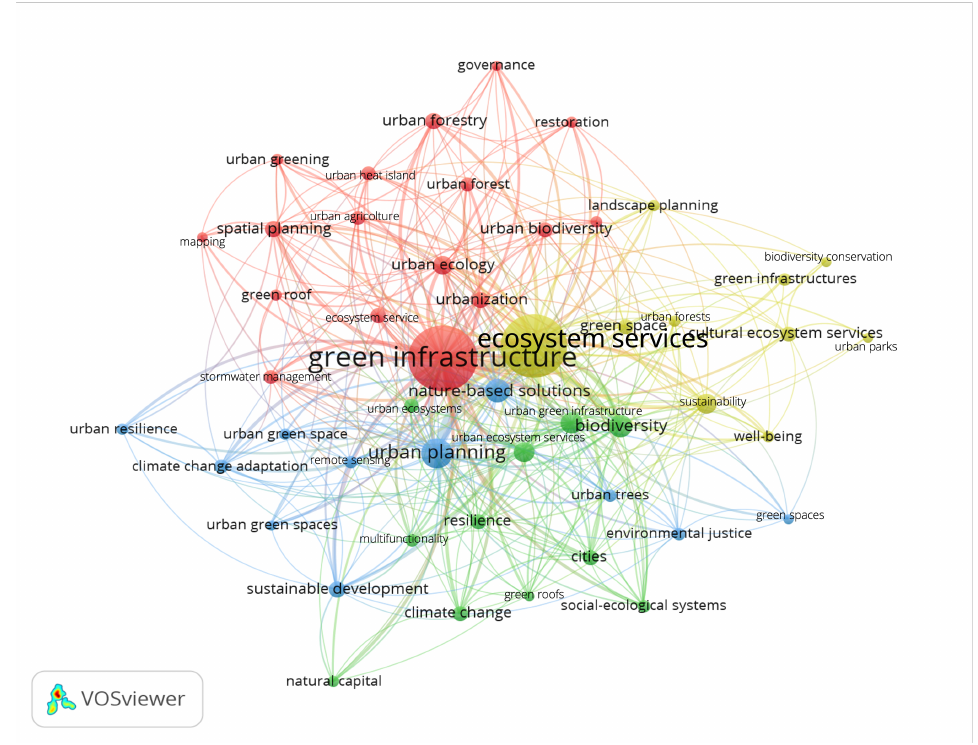
Figure 3. Network Analysis